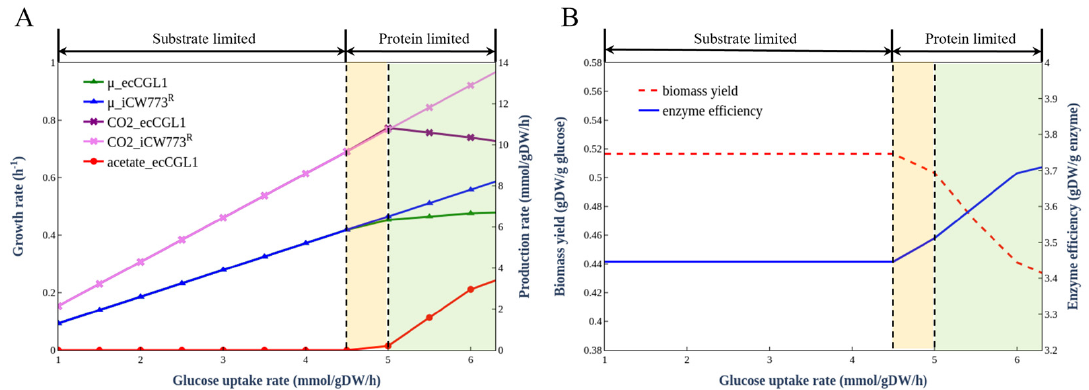
Figure 4. Simulation of overflow metabolism. ( A ) Comparison of in silico overflow metabolism between iCW773 R and ecCGL1. ( B ) Trade-off phenomenon simulated by ecCGL1.